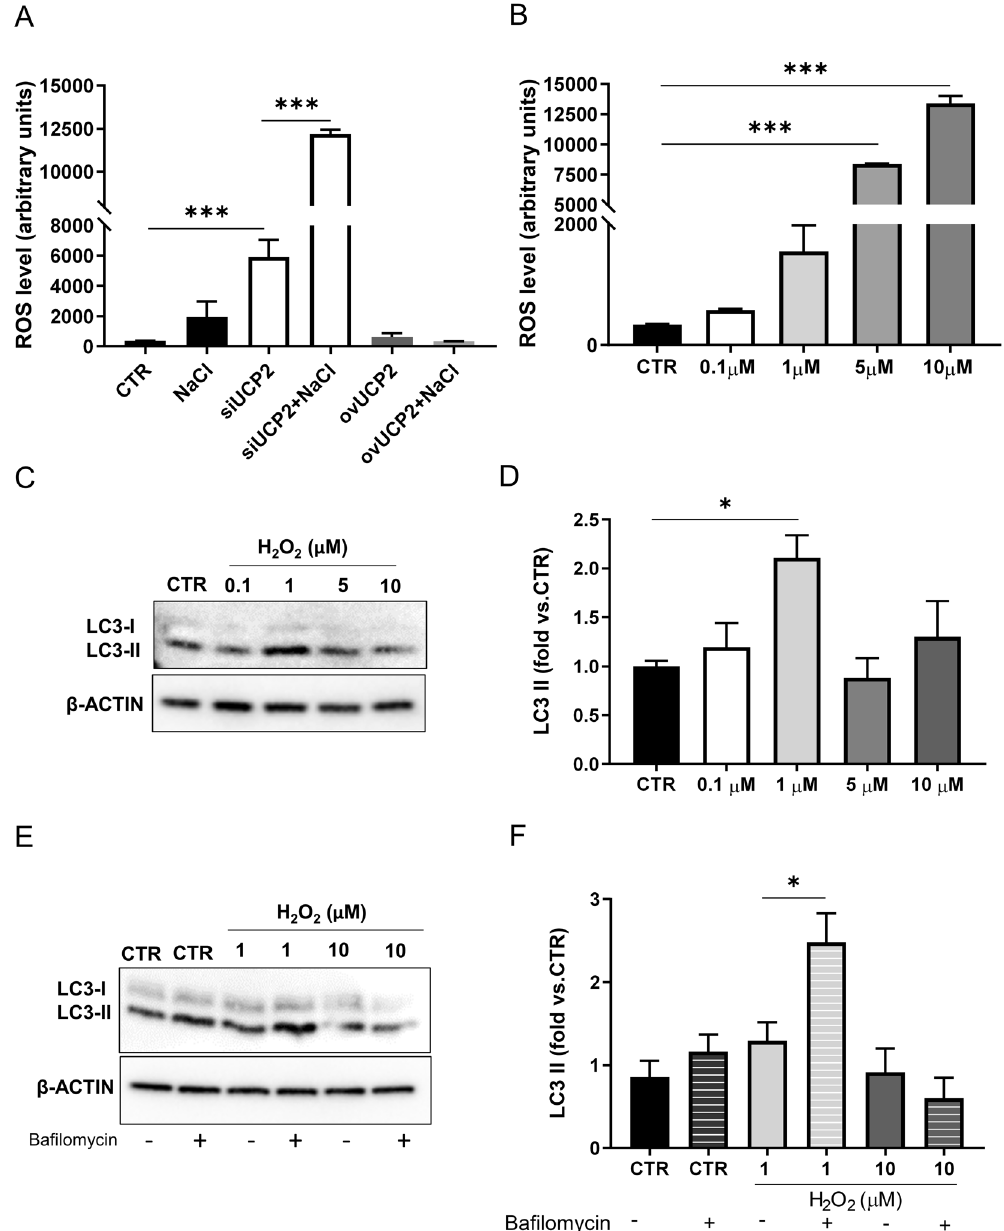
Fig. 8 UCP2 gene silencing leads to ROS-induced inhibition of autophagy. A ROS levels were assessed in microvascular endothelial cells (RBMEC) silenced for 24 h for UCP2 (siUCP2) or transfected with a plasmid overexpressing UCP2 (ovUCP2), either in the presence or in the absence of high-salt treatment (NaCl 20 mM) for 72 h ( N = 8) B ROS levels were assessed in RBMEC after treatment with different concentrations of H 2 O 2 for 12 h (N = 3). C , D Evaluation of autophagy in RBMEC after treatment with different concentrations of H 2 O 2 for 12 h. Representative western blot of LC3-I/II ( C ) and corresponding quanti fi cation ( D ) are shown ( N = 6). E , F Autophagic fl ux evaluation in RBMEC after treatment with different concentrations of H 2 O 2 for 12 h either in the presence or in the absence of 100 nM ba fi lomycin for the last 3 h. Representative western blot of LC3-I/II ( E ) and corresponding quanti fi cation ( F ) are shown ( N = 6). CTR indicates not transfected and not treated cells. * p < 0.05, *** p < 0.001 obtained using the one-way ANOVA followed by Bonferroni post hoc analysis. Data are reported as mean ±